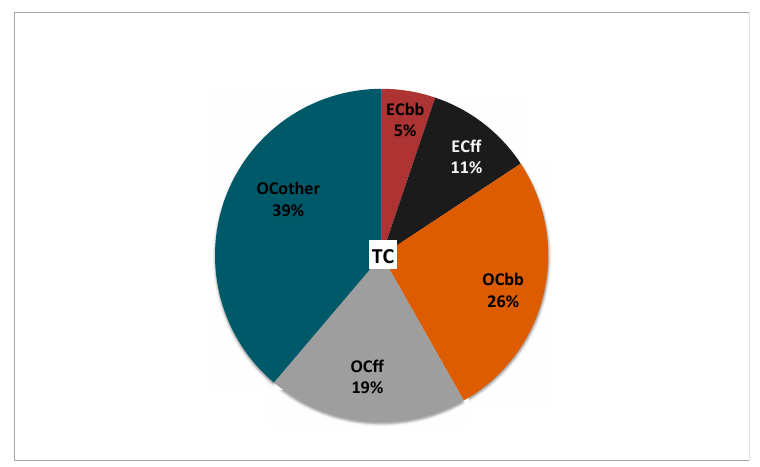
Figure 7. Summary of partitioning results. PM 2.5 carbonaceous fractions, i.e., TC, split into different sources according to the 14 C-based source apportionment.